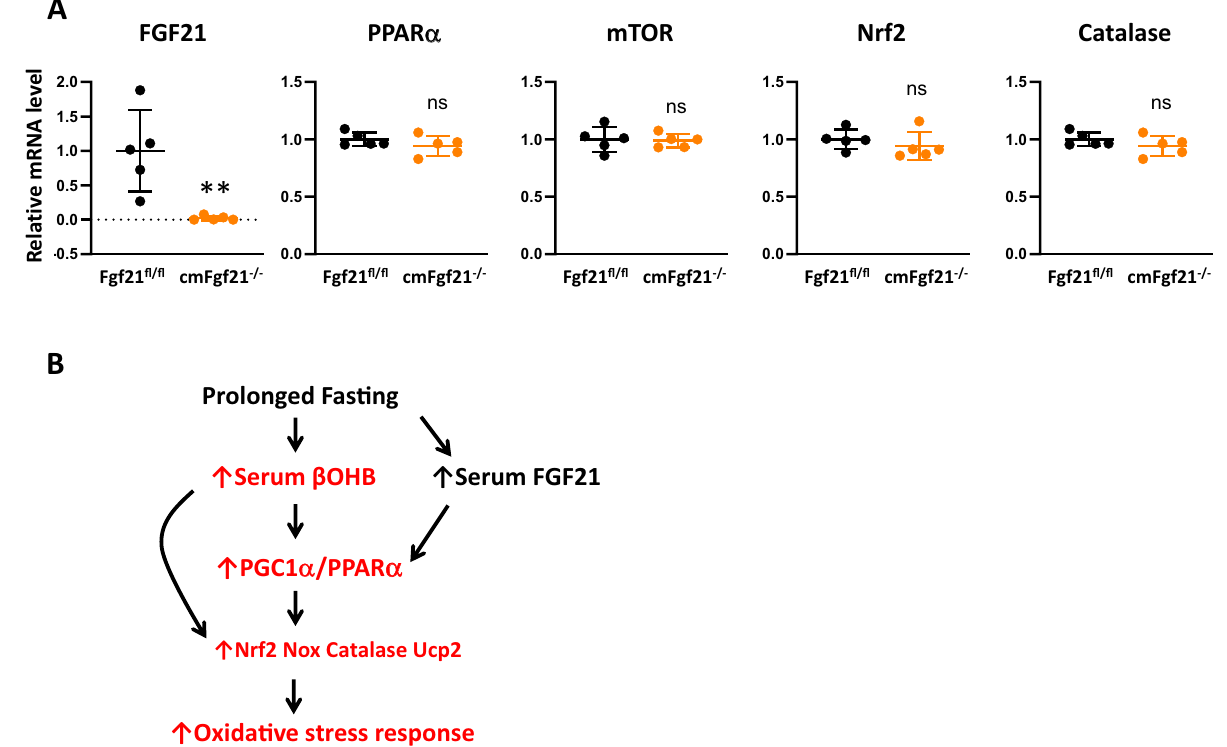
Figure 8. Cardiac gene expression in response to fasting in cmFgf21 −/− mice. ( A ) qPCR analysis of FGF21, PPARα, mTOR, Nrf2, and catalase mRNA levels in the heart in cmFGF21 −/− and FGF21 fl/fl mice subjected to a 24-h fast. Data are mean ± SD (n = 5). **p < 0.01 vs control analyzed by unpaired Student’s t-test. ( B ) Proposed scheme for the role of βOHB and FGF21 in the regulation of oxidative stress response gene expression during fasting in the heart. Prolonged fasting increases circulating levels of βOHB and FGF21, which promote Nrf2 and its downstream oxidative response genes (Nox4, catalase, Ucp2), partly through the PGC1α/PPARα signaling pathway. In Fgf21 −/− mice, such a response is induced to a greater extent by more increased levels of serum βOHB. Pathway promoted in Fgf21 −/− mice is indicated by